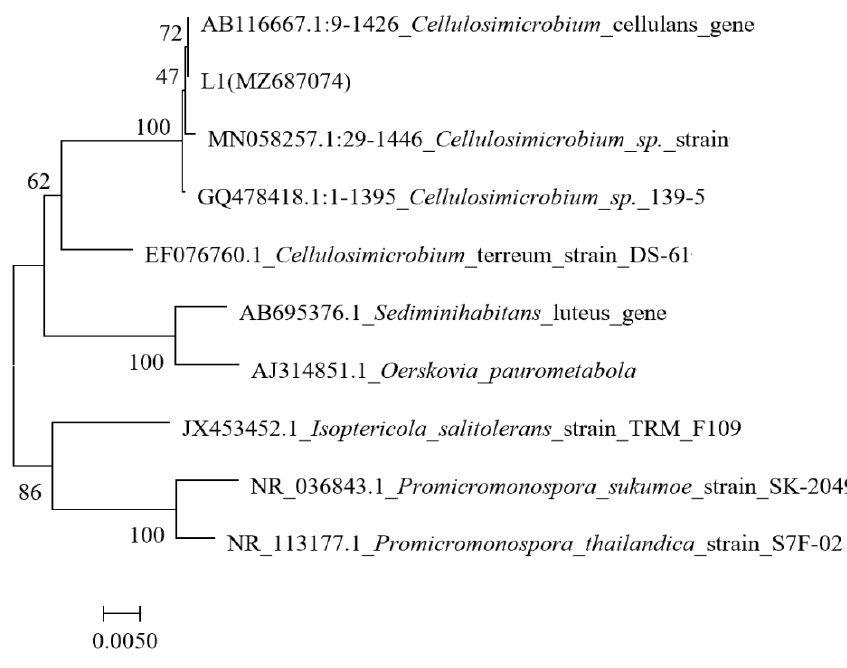
Figure 2. Phylogenetic tree of strain L1 (the neighbor-joining method was used); the scale bars represent 0.005 substitutions per site.